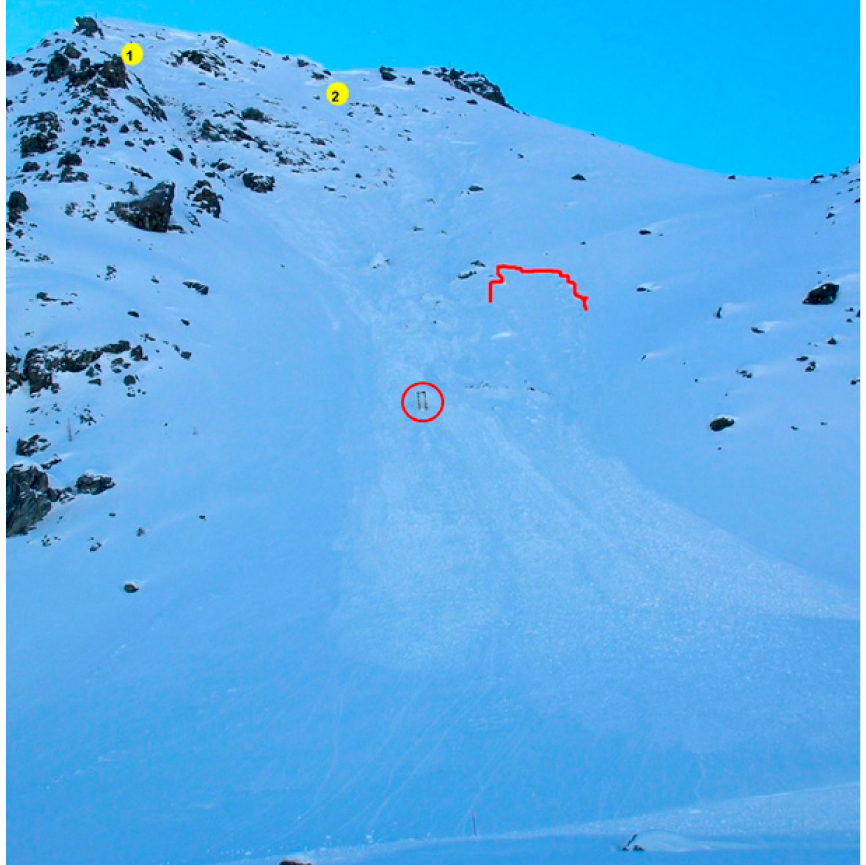
Figure 5. Overview of the 5 March 2011 avalanche. The yellow dot indicates the triggering points and the red circle the obstacle; the red line highlights the secondary release induced by the first flow. Photo M. Freppaz.